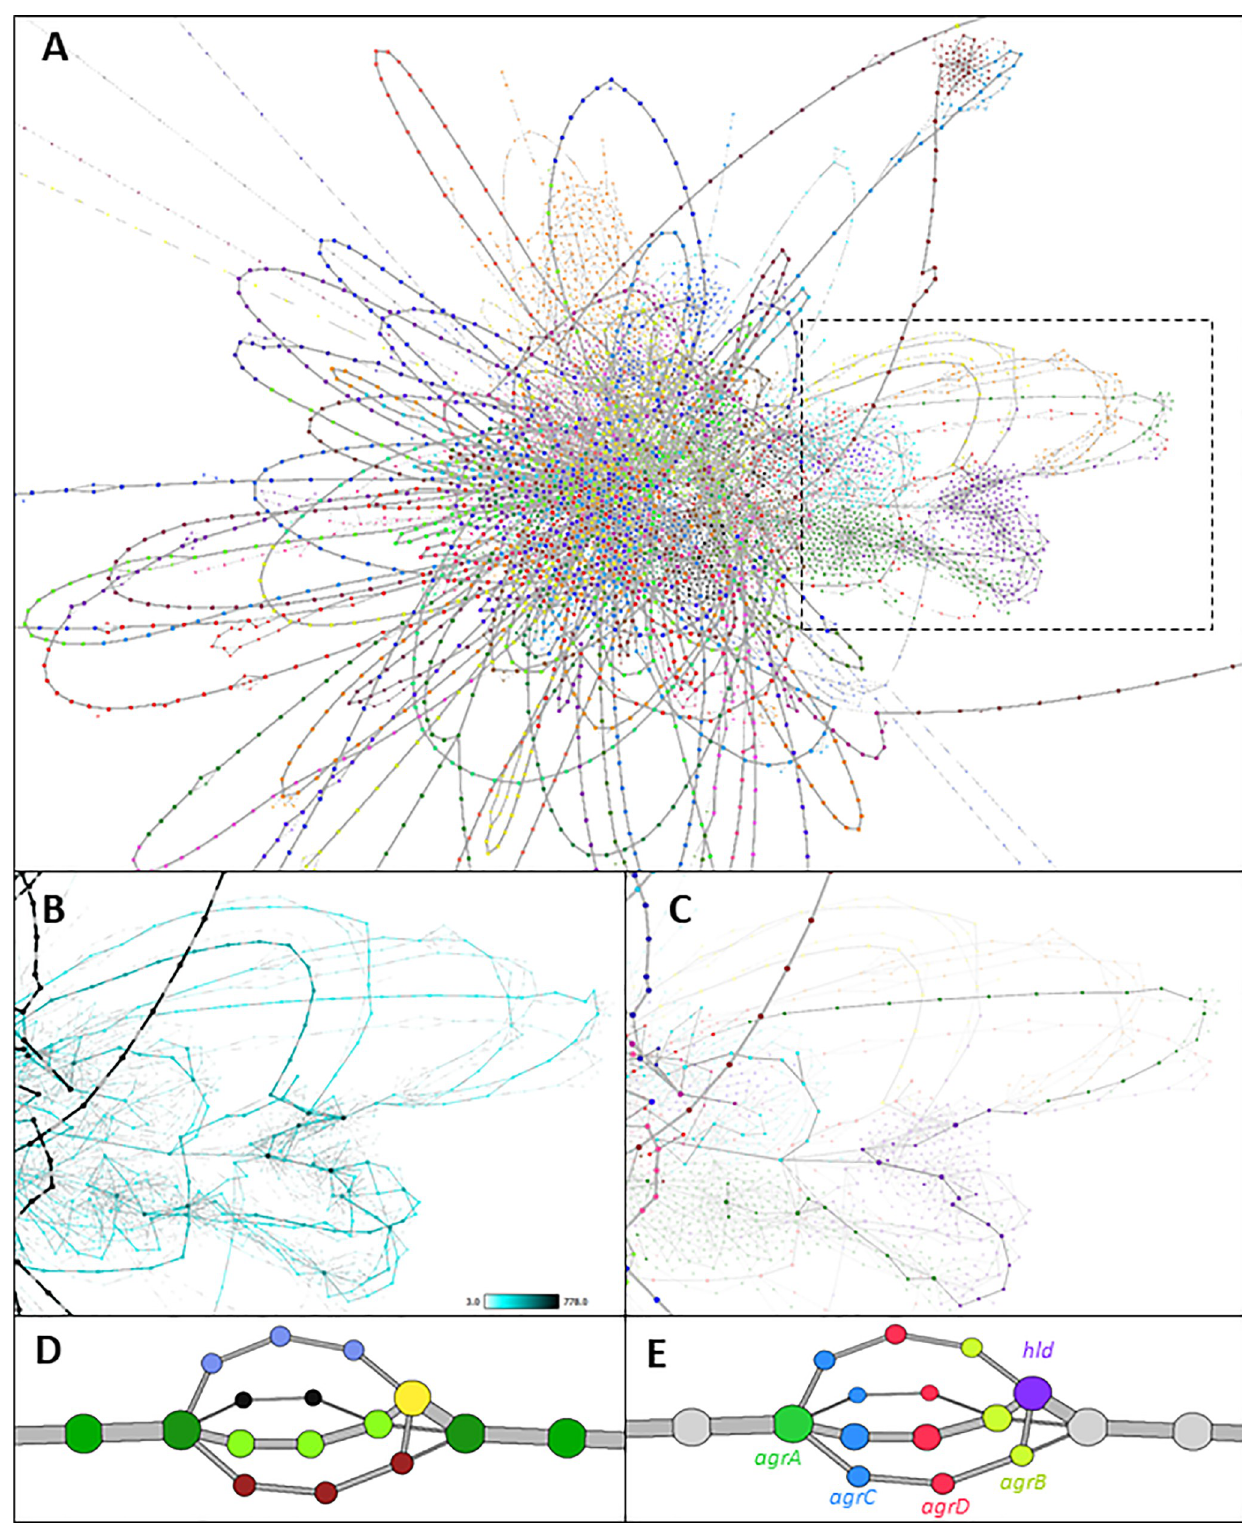
Fig 5. Visualisation of the pangenome of Staphylococcus aureus . (A) The full pangenome of 778 isolates. Nodes represent individual orthologous genes as identified by PIRATE. Node size is determined by the number of genomes in which a gene has been identified. Edges denote where two genes are syntenic,